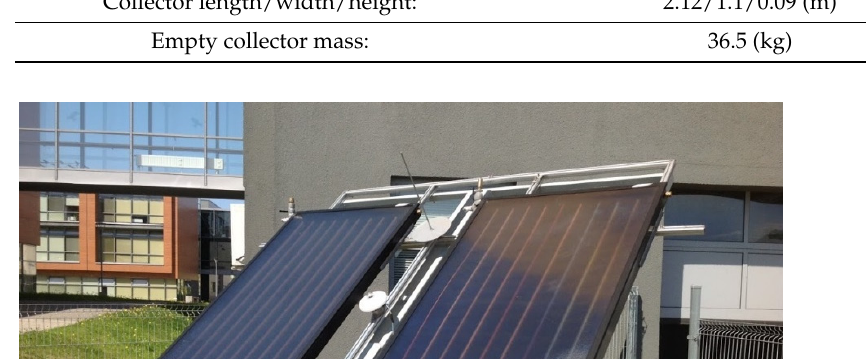
Table 5. Technical specification of the KSH-2.0 collector.